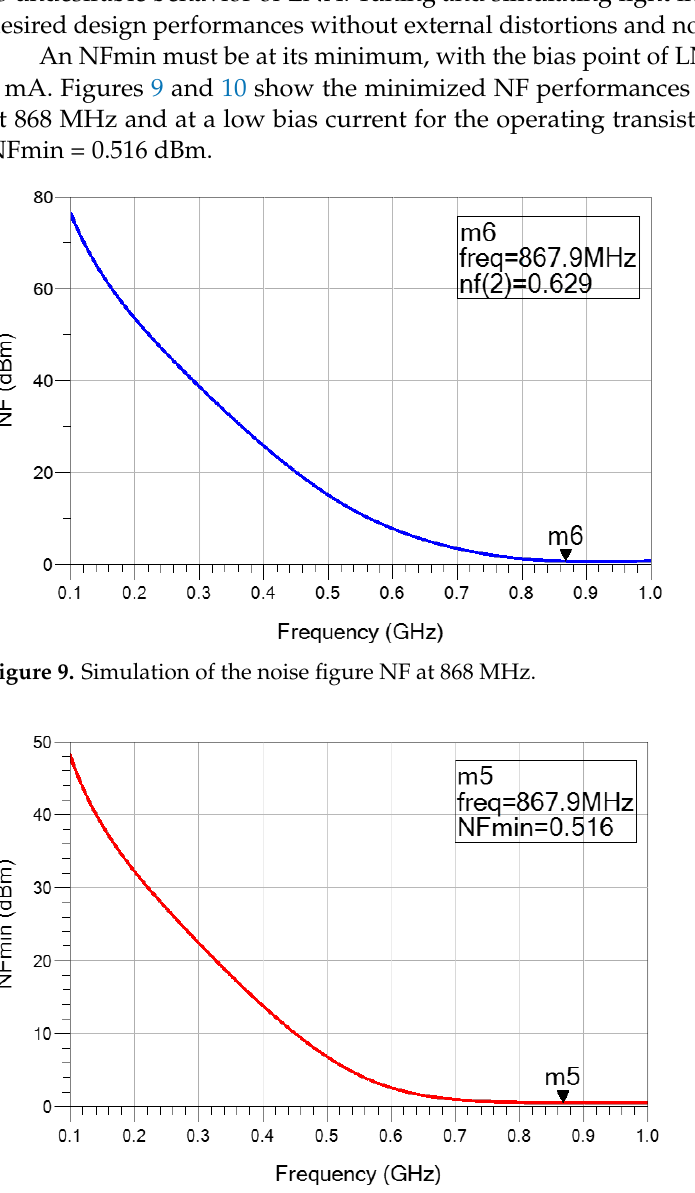
Figure 10. Simulation of the NFmin at 868